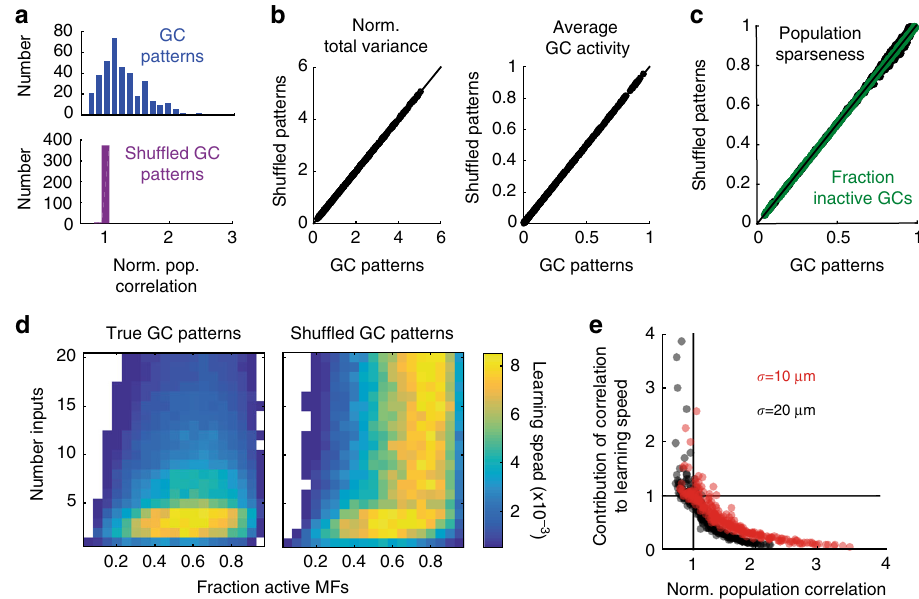
Fig. 5 Separation of the effects of correlation on learning speed from expansion and population sparsening. a Histograms of the normalized population correlation (granule cell correlation/mossy fi ber correlation) for granule cell (GC) patterns (top, blue) and shuf fl ed GC patterns (bottom, purple). The narrow distribution around 1 indicates that the shuf fl ed GC patterns have the same normalized population correlation as the mossy fi ber (MF) patterns. b Normalized total variance (left) and average activity (right) for GC patterns (abscissa) versus shuf fl ed GC patterns (ordinate). c Population sparseness (green) plotted for GC patterns (abscissa) and shuf fl ed GC patterns (ordinate). Green indicates the fraction of inactive GCs for comparison as an alternate measure of population sparseness. d Raw learning speed for true GC patterns (left) and shuf fl ed GC patterns (right). In both panels, MF inputs are correlated with a correlation radius of σ = 20 μ m. e Change in learning speed due to correlations (i.e., GC speed/shuf fl ed GC speed) plotted against the normalized population correlation. Each point represents different values of N syn and f MF . Correlation radii were σ = 10 μ m (red) or 20 μ m